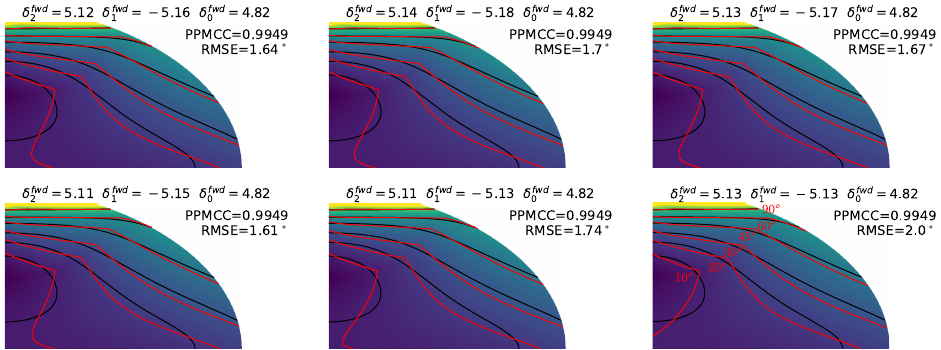
Figure 11. Distribution and contours (in red) of FWD–GCA metric for evaluating Winkel Tripel projection using rational function–based regression with different regression coefficients.